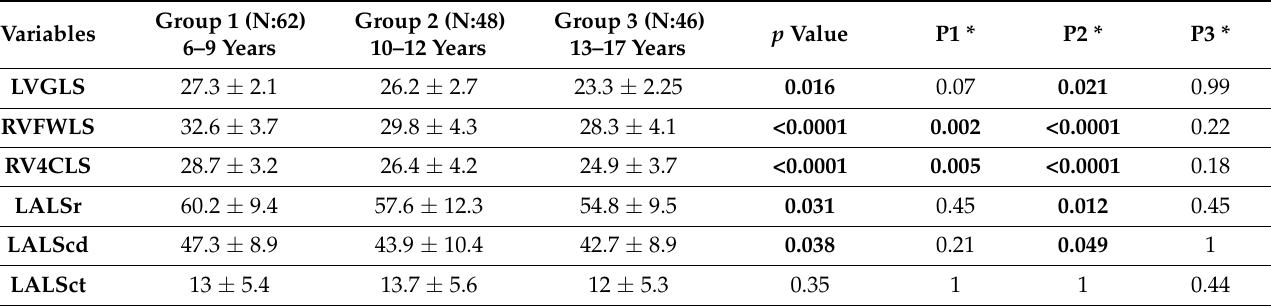
Table 5. Strain values categorized by age groups.